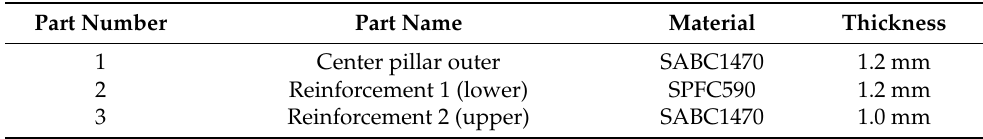
Table 3. Properties of center pillar with steel reinforcements.